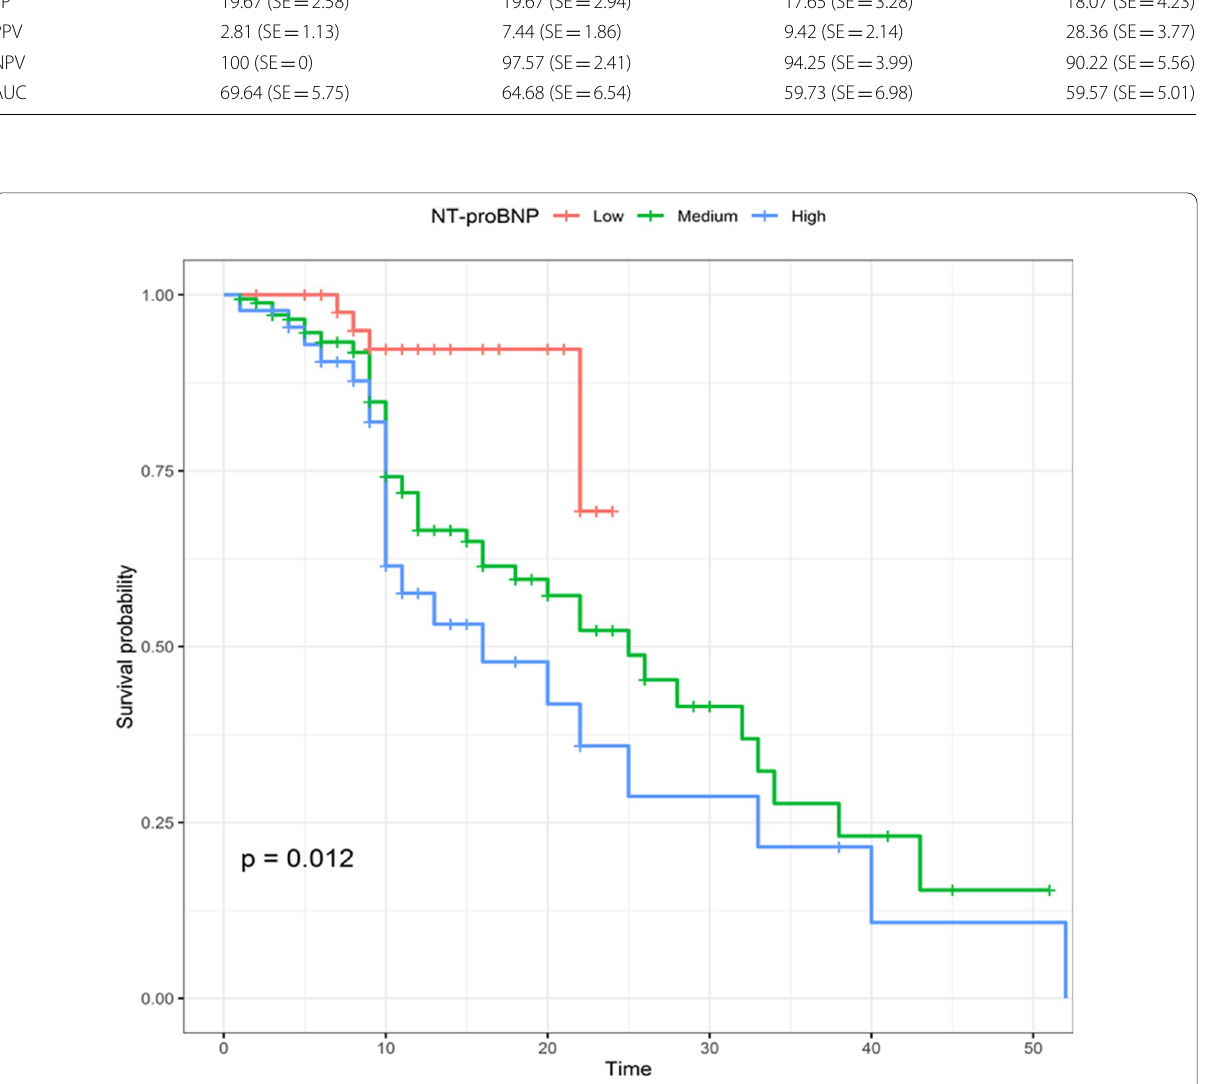
Fig. 2 Kaplan–Meier curve of the cumulative survival rate of patients with COVID-19 categorized into three groups based on NT-proBNP cut points. Red line is for NT-proBNP 331; green line is for 331 < NT-proBNP 11,121; Blue line is for NT-proBNP > ≤ ≤